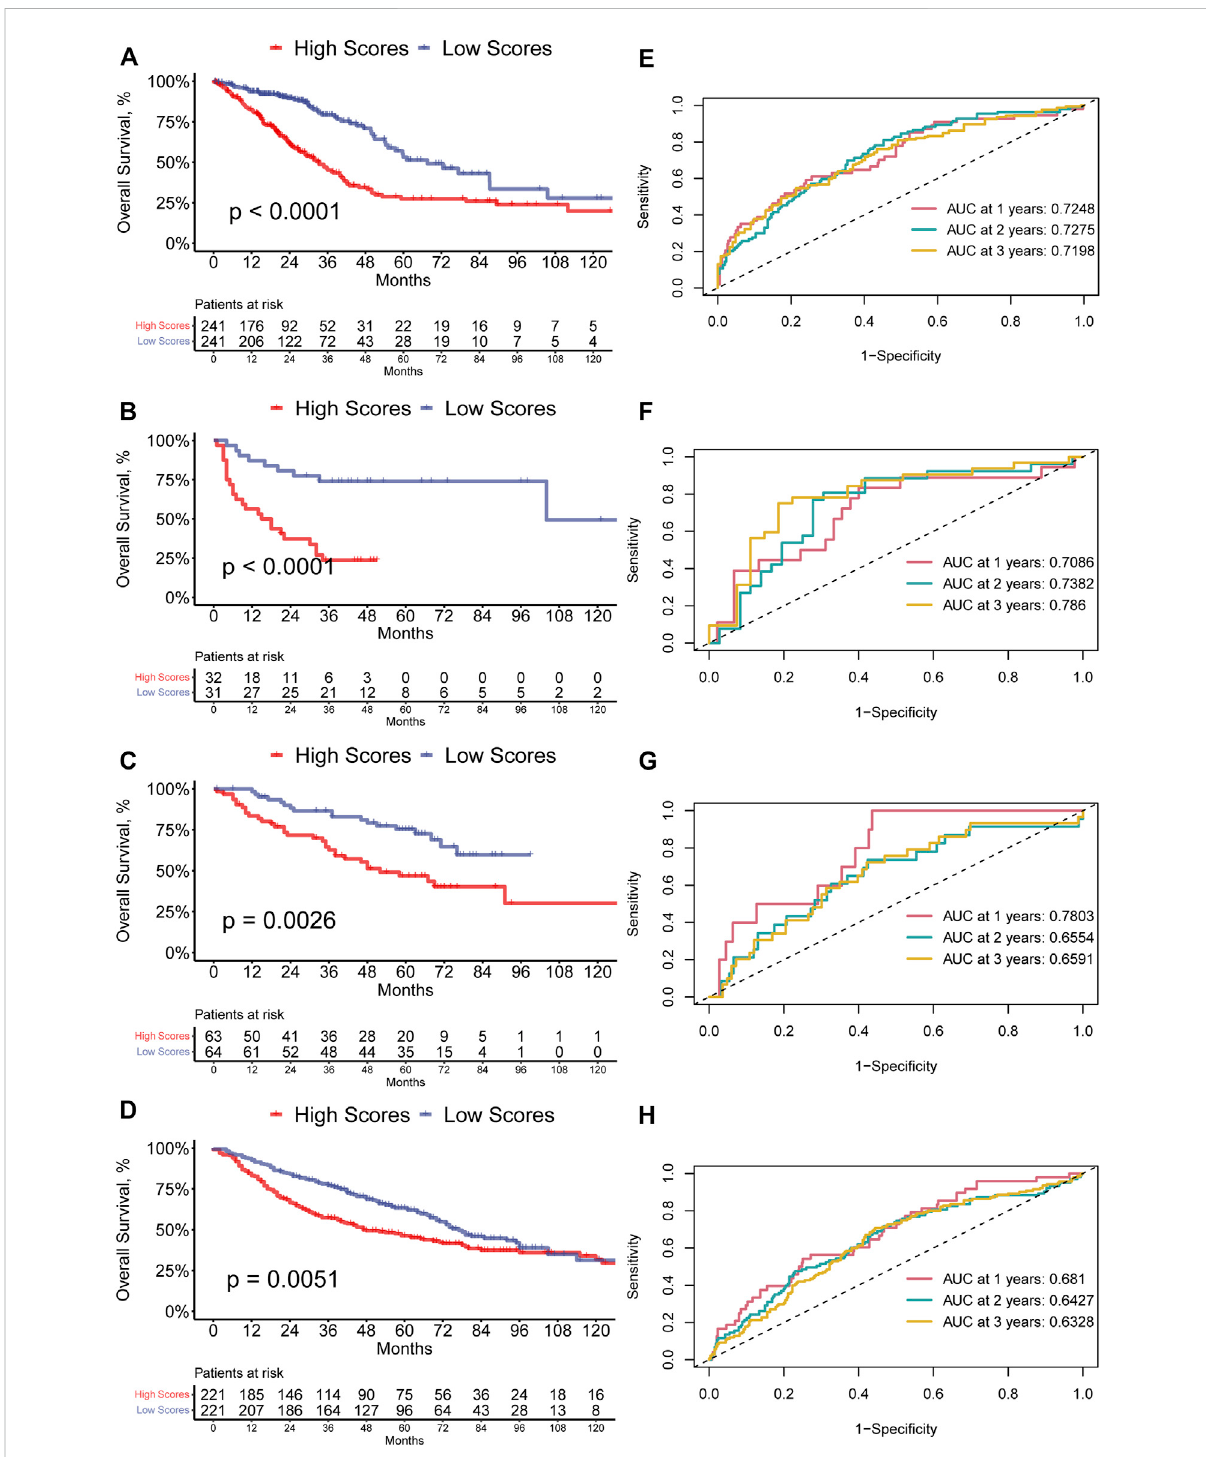
FIGURE 3 (A – D) Kaplan – Meiercurvesofhigh-andlow-RSLUADpatientsintheTCGA,GSE8894,GSE50081,andGSE68465cohort. (E – H) ROCcurvesof one-, two-, and 3-year OS for LUAD patients based on the RS in the TCGA, GSE8894, GSE50081, and GSE68465